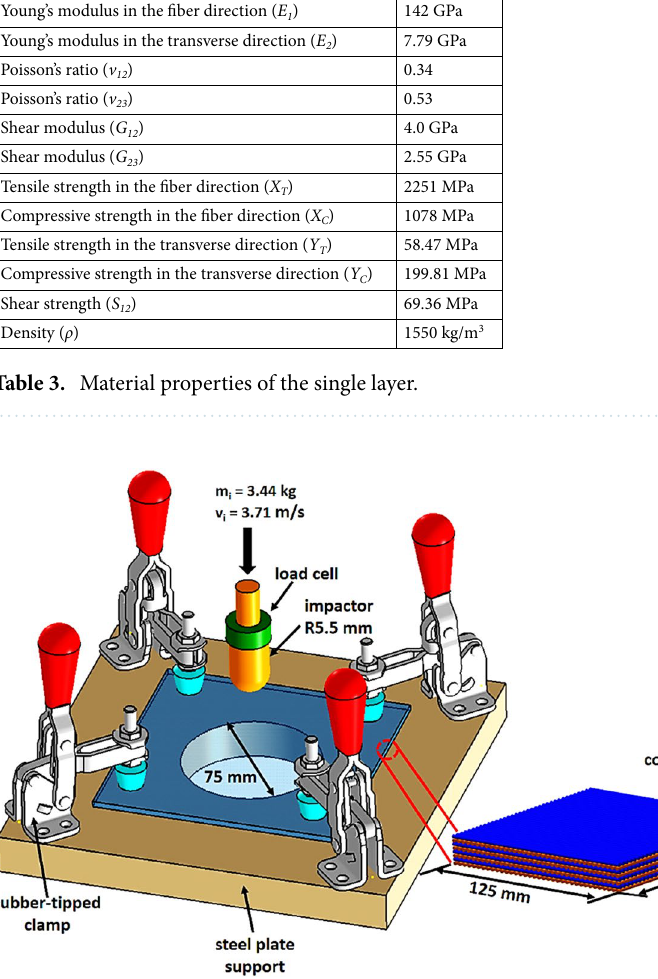
Figure 12. Schematic diagram low-velocity impact test for quasi-isotropic composite